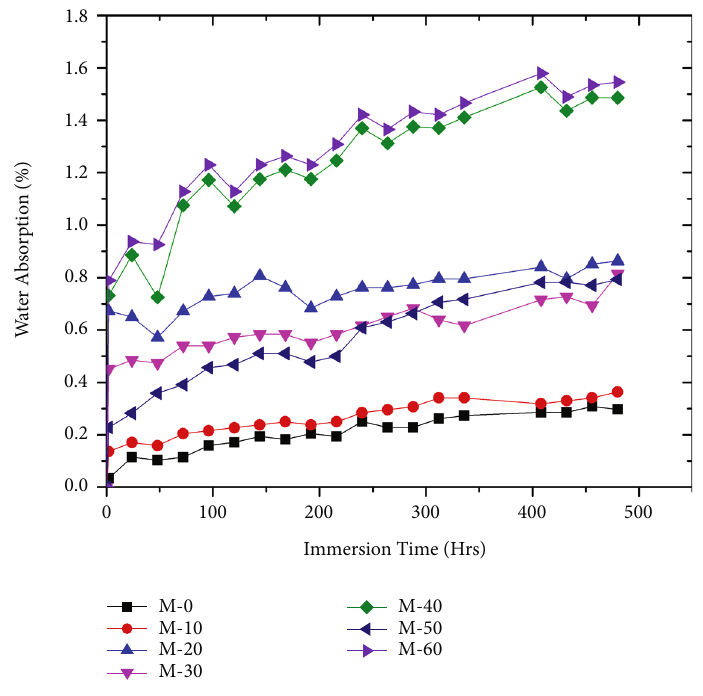
Figure 16: Water absorption behavior of mango seed shell/epoxy